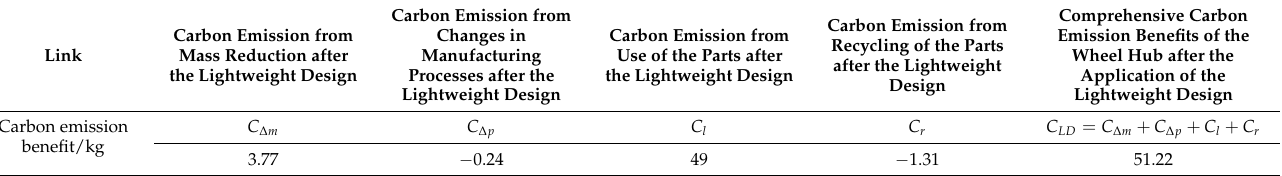
Table 4. Carbon emission benefits of each link caused by the lightweight design.